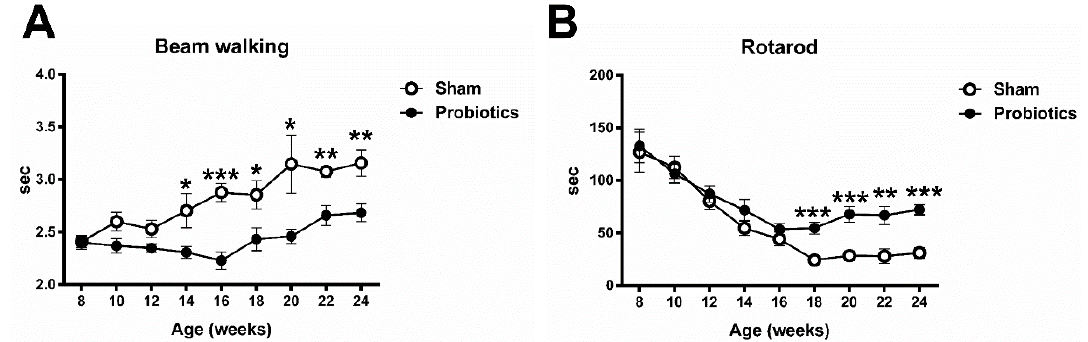
Figure 2. The effect of long-term probiotic administration on balance function ( A ) and motor coordination ( B ) evaluated by the beam walking test and rotarod test, respectively. The duration of the elapsed time for the probiotic-treated PD mice was significantly lower than that of the sham-treated PD mice after the age of 14 weeks. In the rotarod test, the latency for the probiotic-treated mice was significantly longer than that of the sham-treated mice after the age of 18 weeks. Values are presented as the mean ± SEM. * p < 0.05, ** p < 0.01, *** p < 0.001, significant differences between two groups.